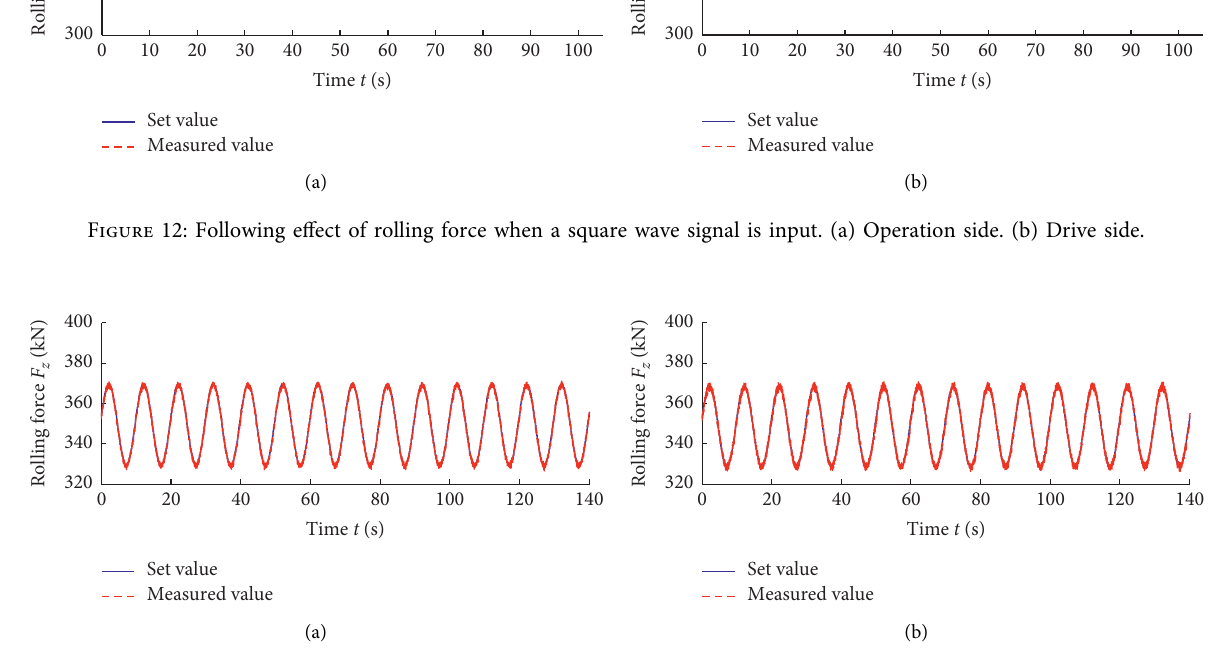
Figure 13: Following effect of rolling force when a sine signal is input. (a) Operation side. (b) Drive side.